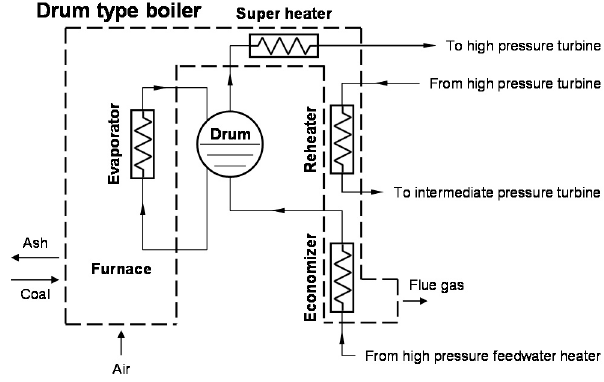
Figure 7. Simplified schematic of the target drum-type boiler [11].